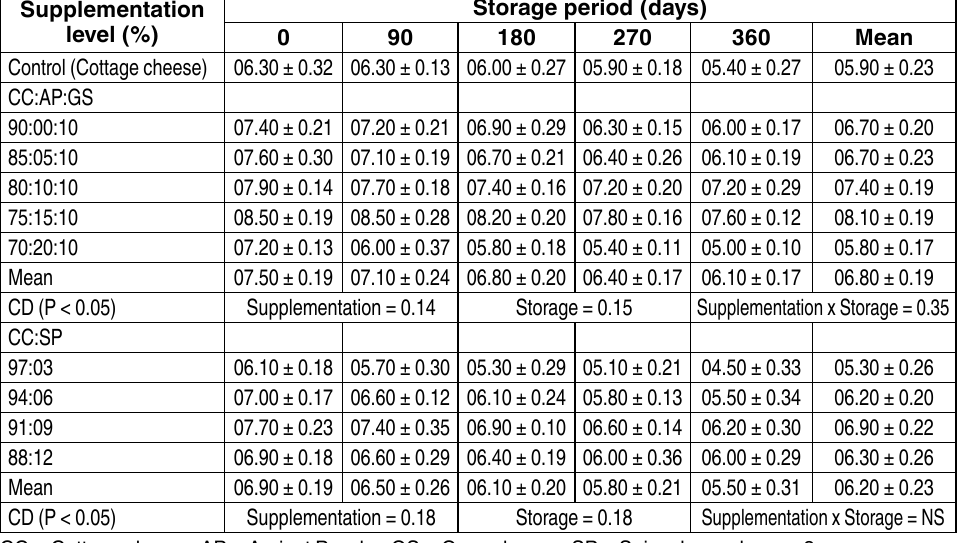
Table 5. Effect of supplementation and storage on overall acceptability of value-added churpe products (balls and